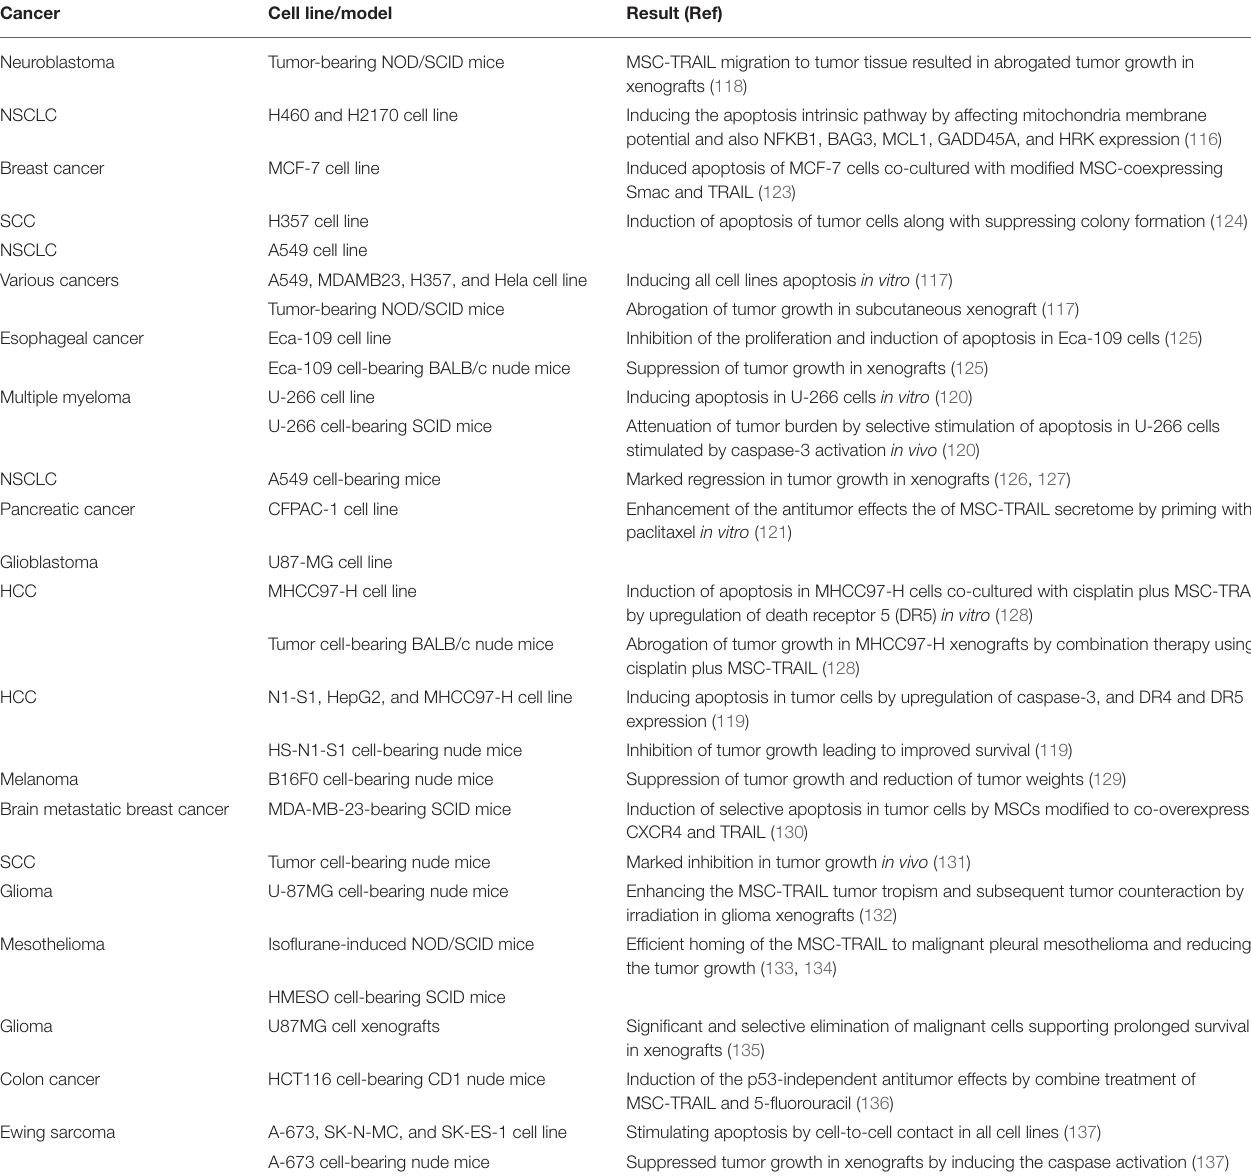
TABLE 4 | The overview of studies based on the use of mesenchymal stem/stromal cells (MSCs) as a carrier for delivery of TRAIL to treat human tumors ( in vitro and in vivo ).